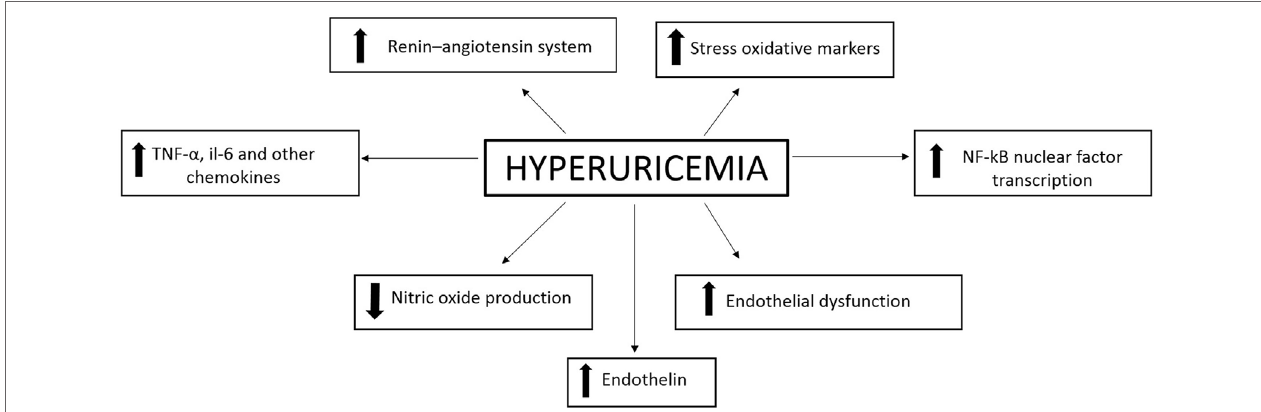
FigURe 1 | Mechanisms through which hyperuricaemia leads to cardiovascular